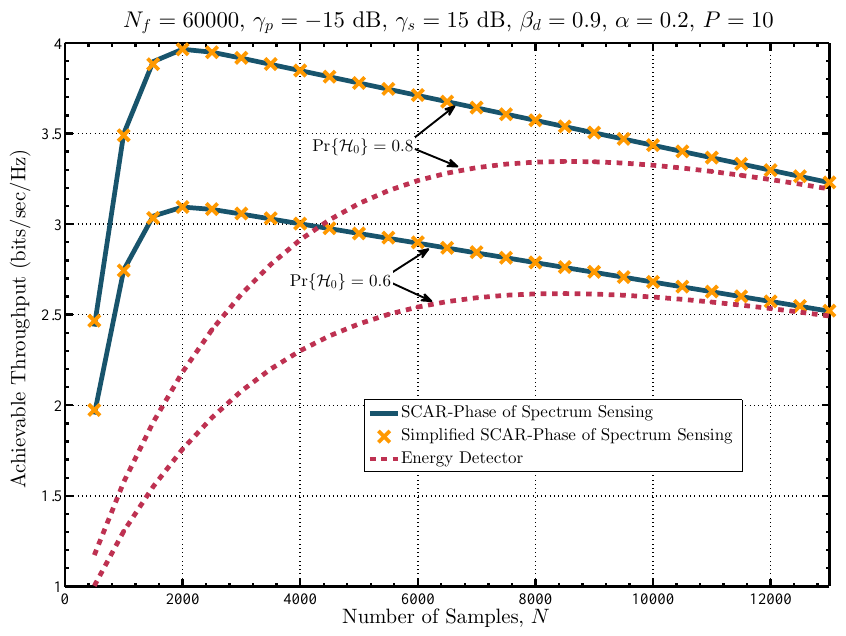
Figure 11. Achievable throughput for the secondary